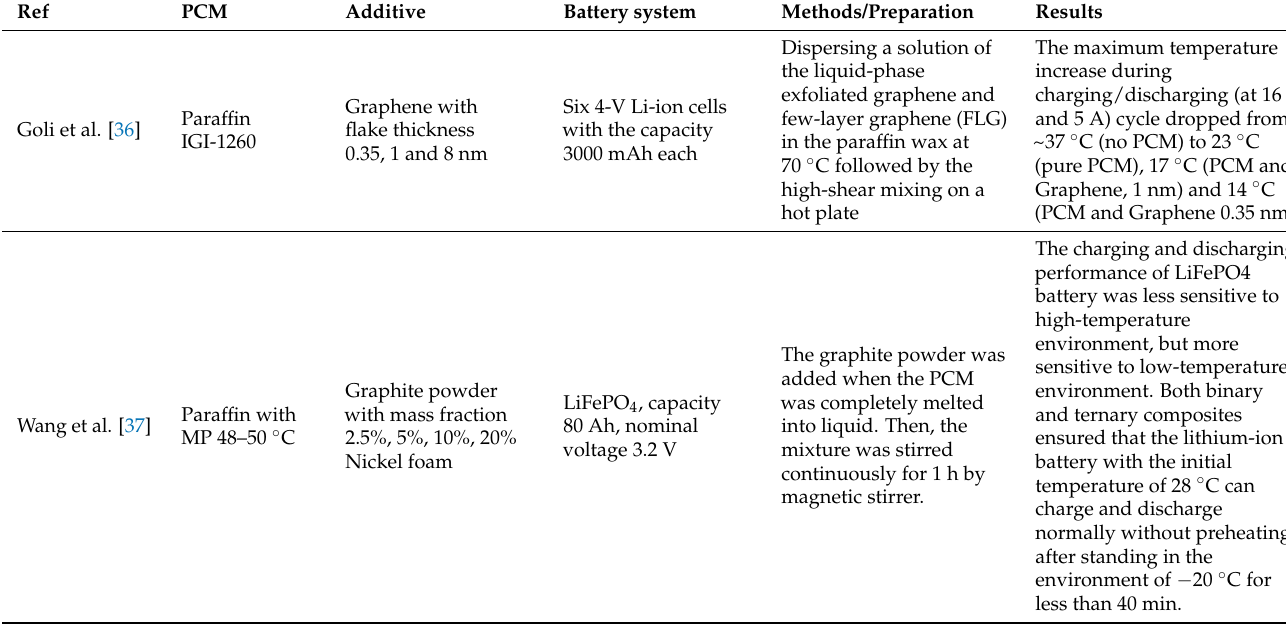
Figure 5. The experimental set up described in [35]. Reproduced with permission from Elsevier. Table 2. PCM thermal conductivity enhancement with additives for BTMS. Experimental